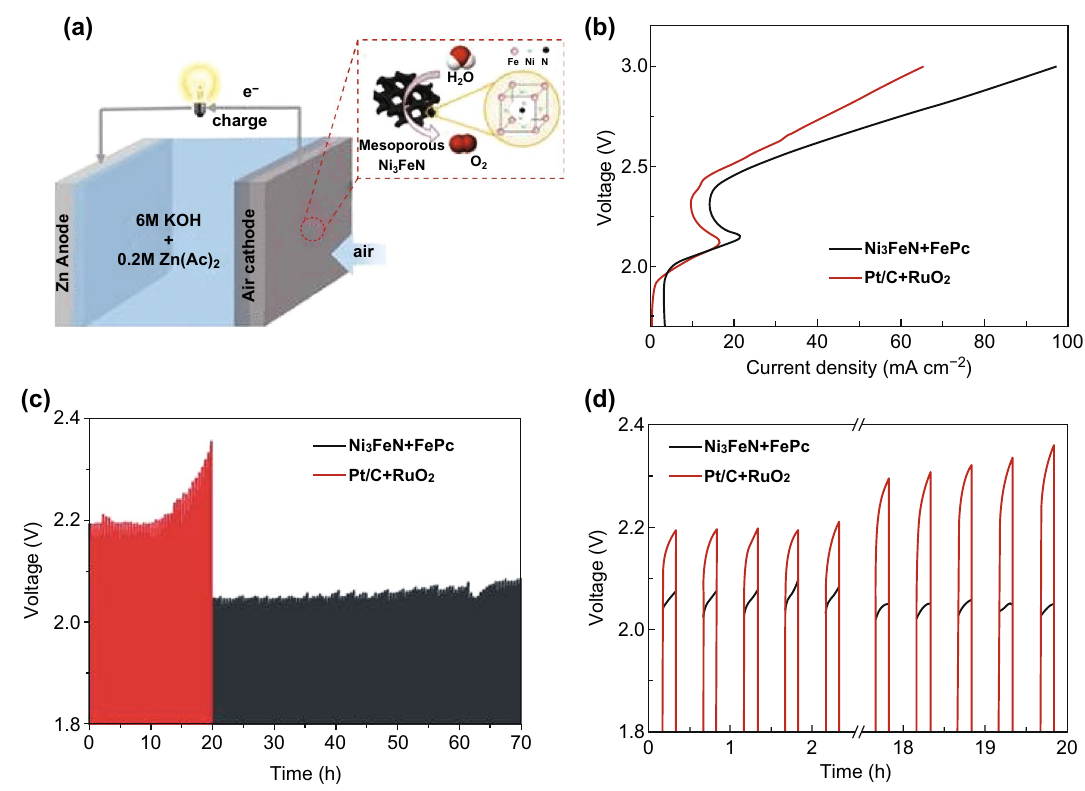
Fig. 6 a Schematic illustration of a rechargeable Zn-air battery (ZAB) using FePc and mesoporous Ni 3 FeN as ORR and OER electrocatalysts in the air cathode, respectively (FePc not shown here); b charge polarization curves for a battery with Ni 3 FeN + FePc and Pt/C + RuO 2 as the air electrode catalysts; c , d charge/discharge cycling of a rechargeable ZAB based on Ni 3 FeN + FePc and Pt/C + RuO 2 at 10 mA cm −2 . Only the charge curves were shown here to highlight the advantages of mesoporous Ni 3 FeN used as OER electrocatalysts in a rechargeable